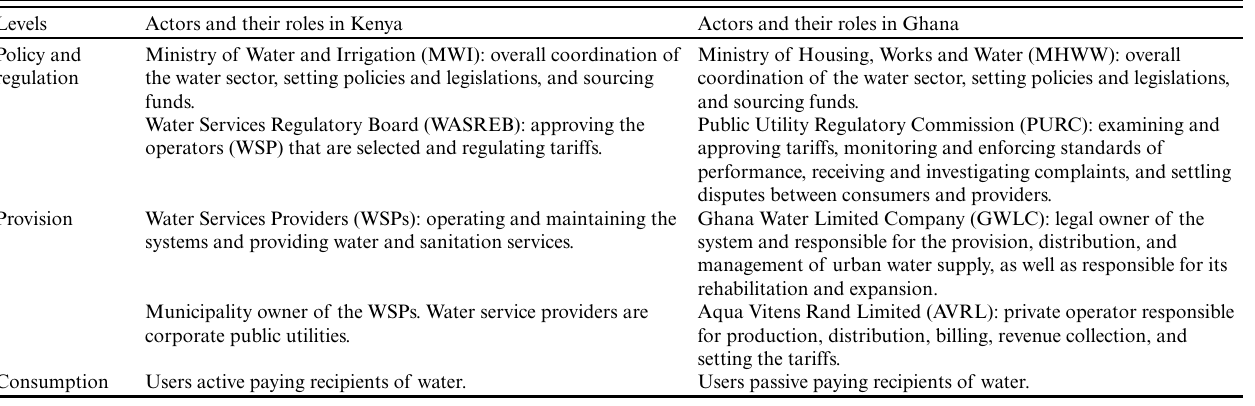
Table 4 . Main actors involved in water service delivery (WSD) in Kenya and their roles. Levels Actors and their roles in Kenya